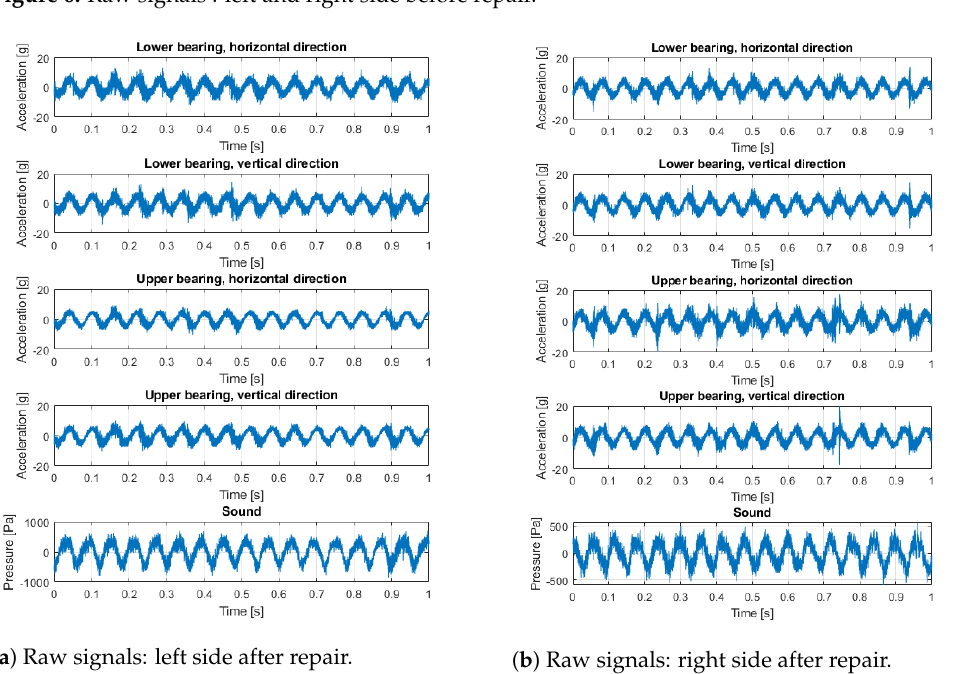
Figure 7. Raw signals: left and right side after